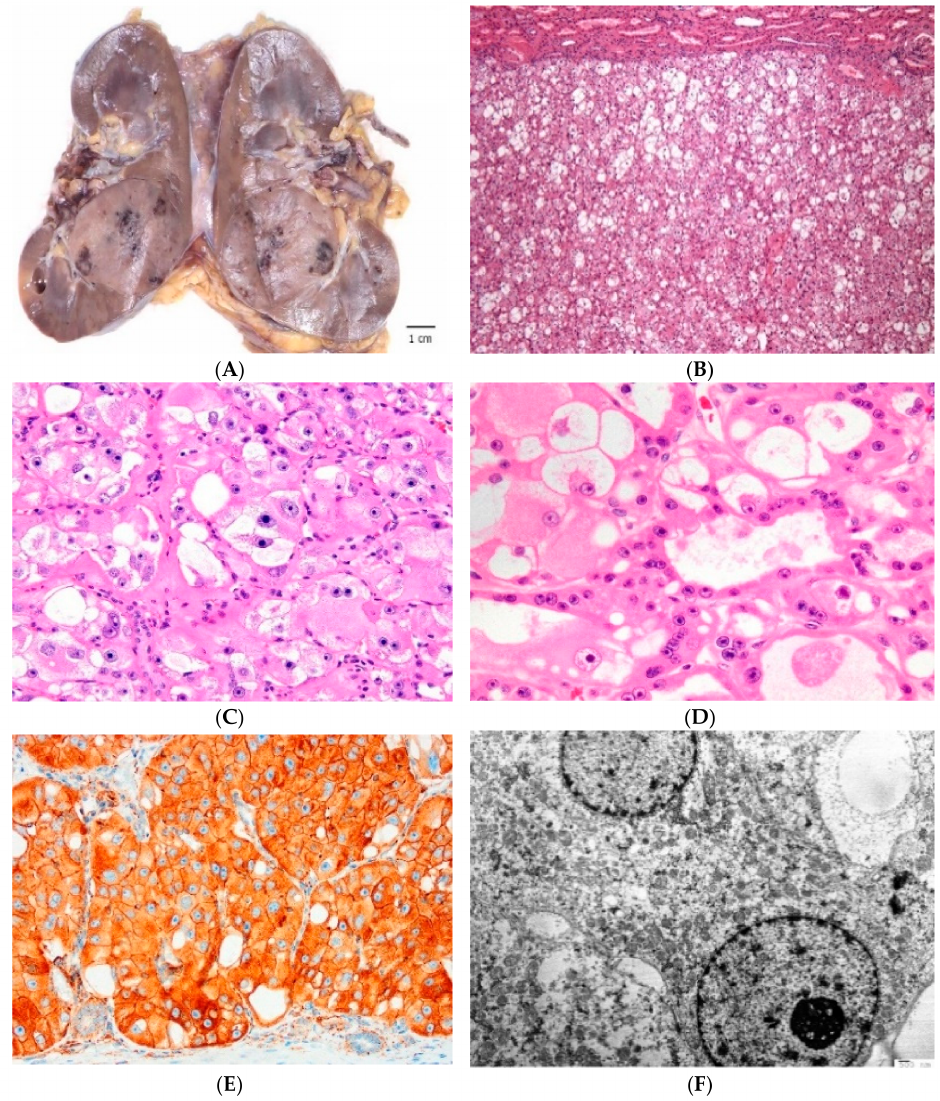
Figure 3. High-grade Oncocytic Tumor (HOT) of kidney often mimics the color of the adjacent renal parenchyma ( A ). It demonstrates solid growth of mostly eosinophilic cells, admixed with ‘clear’ cells with intracytoplasmic vacuoles ( B ). The eosinophilic cells have voluminous cytoplasm with large intracytoplasmic vacuoles; the nuclei show prominent to often very large nucleoli ( C,D ). Cathepsin K is positive on immunohistochemistry ( E ). On electron microscopy, numerous intracytoplasmic mitochondria are present ( F